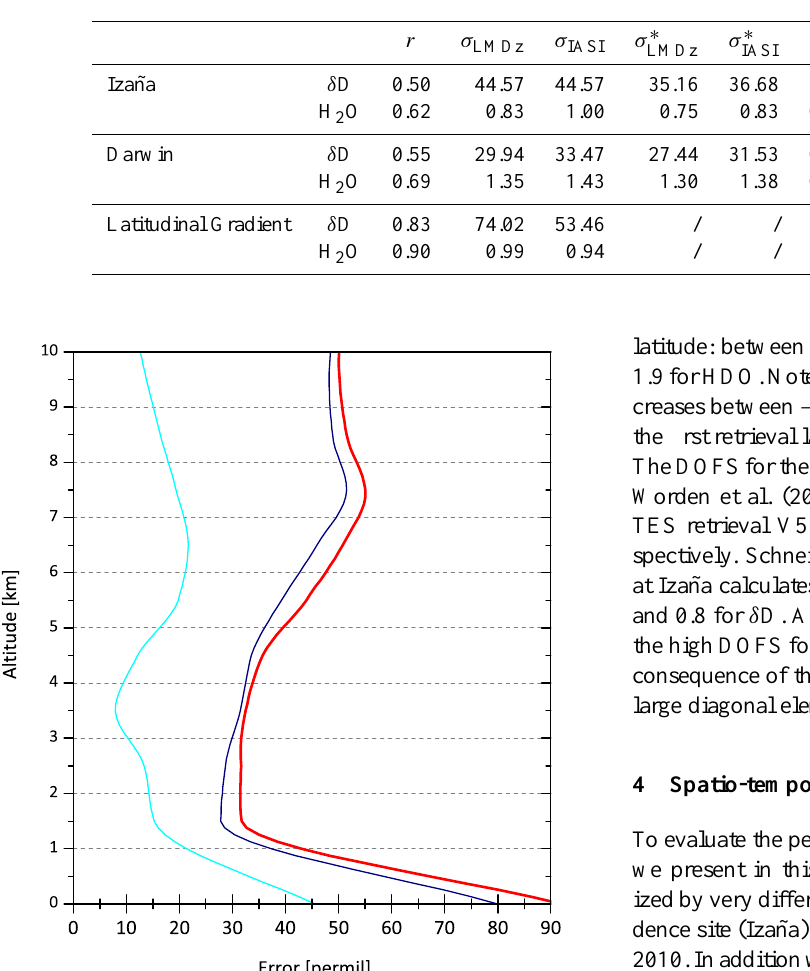
Table 1. Statistics between LMDz-iso simulated and IASI retrieved values for the different datasets presented. r is the correlation co- efficient; σ LMDz and σ IASI are the standard deviations of LMDz-iso and IASI, respectively; R σ the ratio of standard deviations with R σ = σ LMDz /σ IASI ; E is the overall bias ( E = LMDz − IASI); and N the number of values considered. The standard deviations as the overall bias are expressed in permil and in gkg − 1 for δ D and H 2 O, respectively.